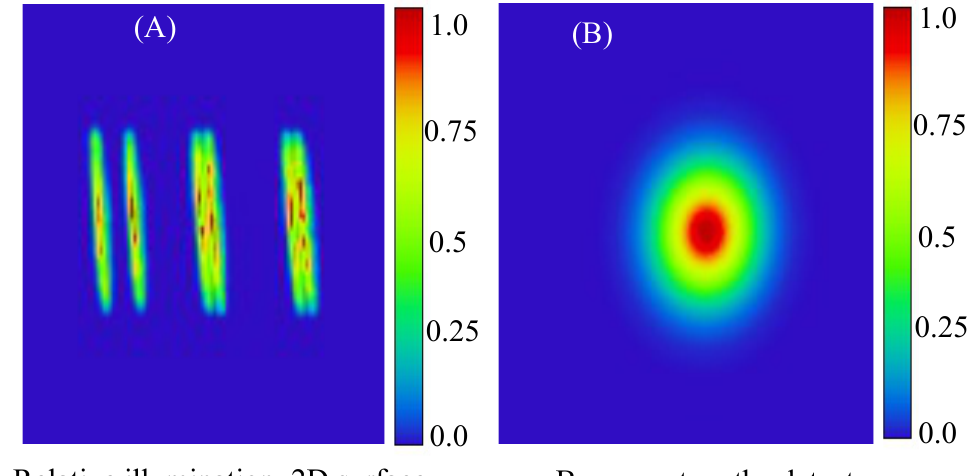
Figure 4. ( A ) Wavelength band imaged on the plane of the detector. ( B ) Irradiance and beam spot at the detector